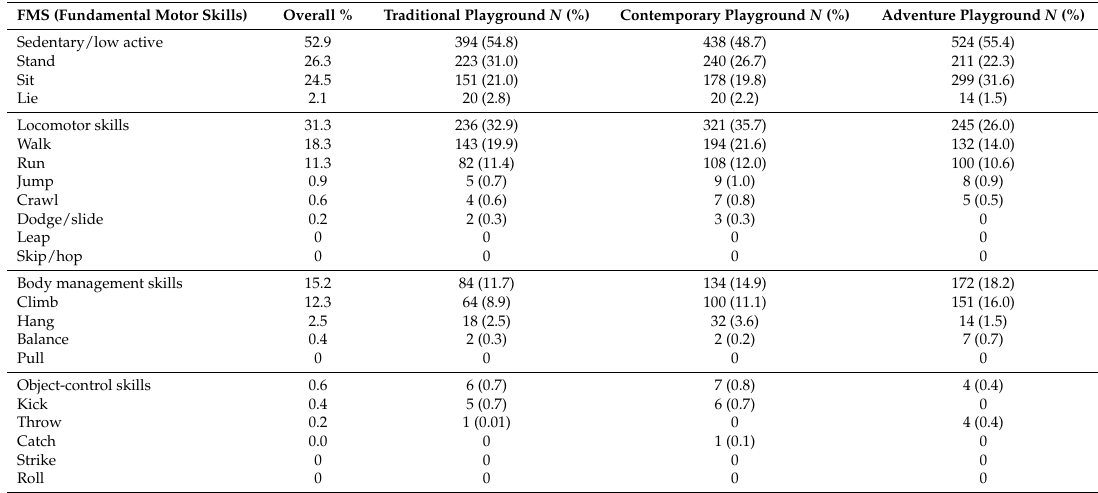
Table 3. FMS (Fundamental Motor Skills) observed at each